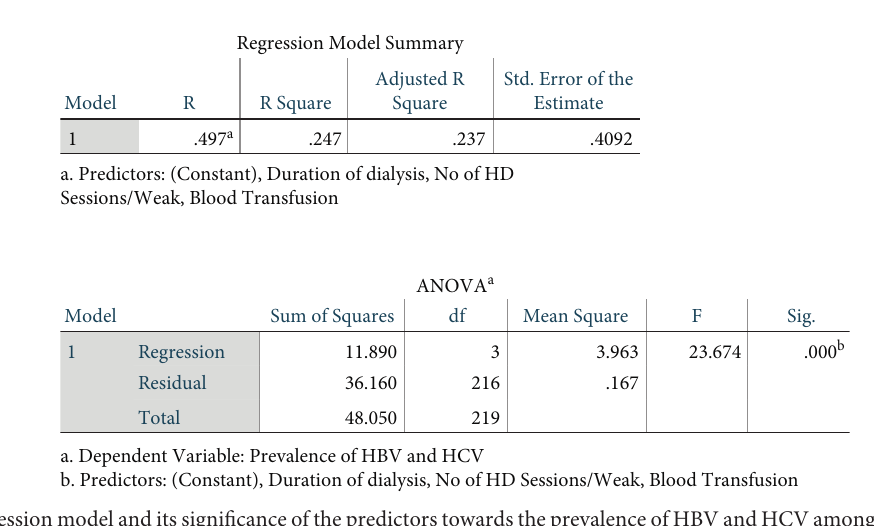
Figure 1: The regression model and its significance of the predictors towards the prevalence of HBV and HCV among hemodialysis